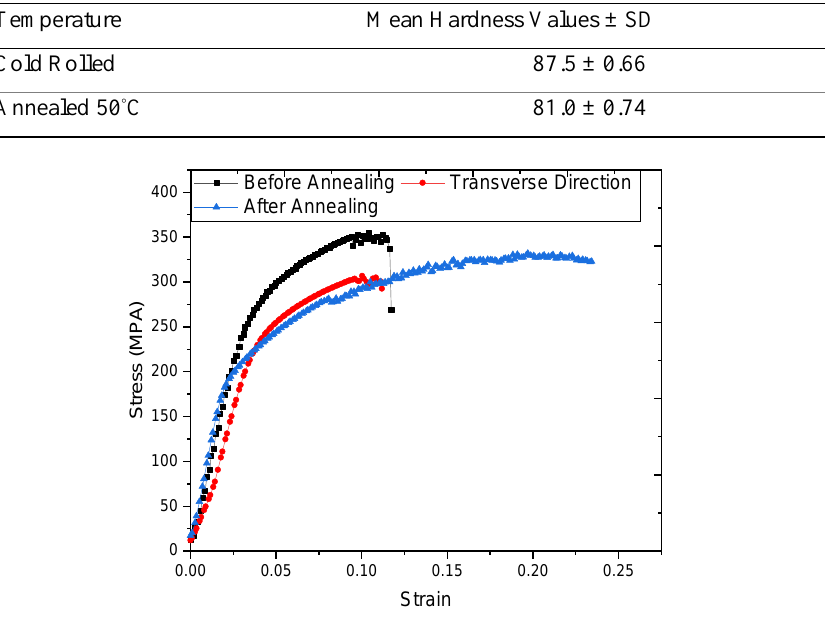
Fig. 6. Tensile testing of cold rolled & 50 ◦ C annealed sample.